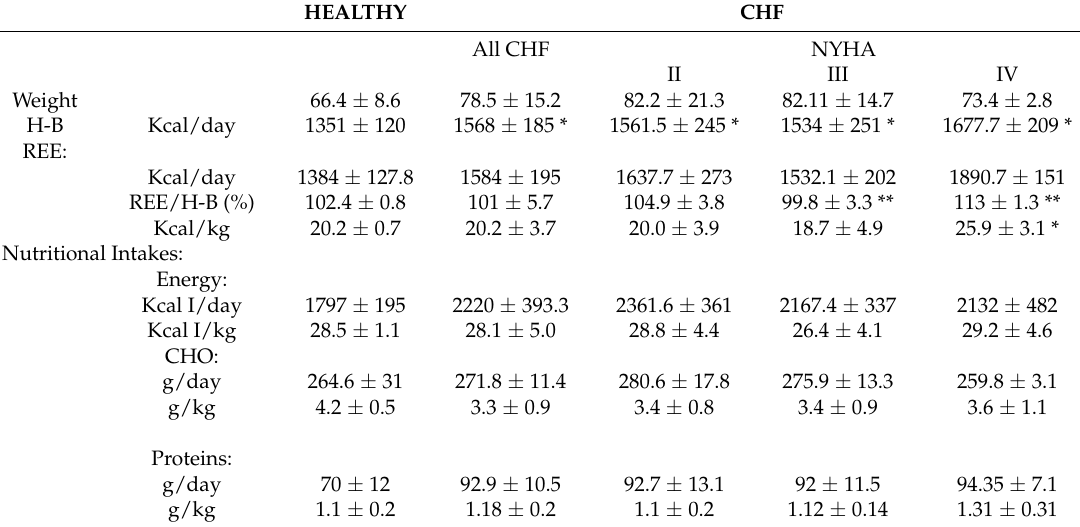
Table 3. Predicted energy expenditure (H-B), resting energy expenditure (REE) and nutritional intakes in chronic heart failure (CHF) patients and in healthy